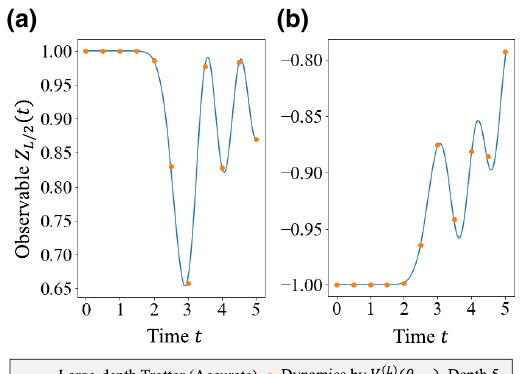
FIG. 7. The real-time dynamics of Z L / 2 (a) from the ferromag- ( 0 ) (cid:4) and (b) netic initial state with two local excitations | ψ ( L ) LE ( 0 ) (cid:4) . The orange dots from the one with two domain walls | ψ ( L ) DW represent the stroboscopic dynamics at t ∈ τ Z under V ( L ) (θ opt ) , implemented with the depth 50 up to t = 5. This well corre- sponds to the blue line, which shows accurate dynamics under the Trotterization with sufficiently large depth 100 per τ =